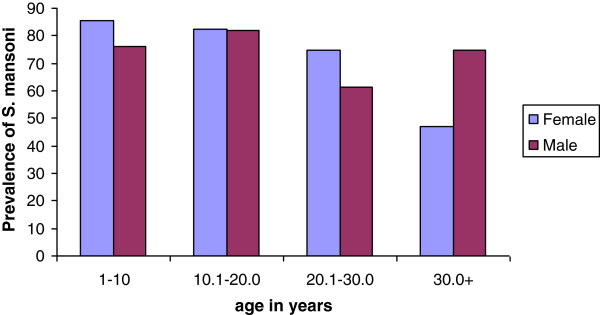
Prevalence of
S. mansoni
by sex, Waja-Timuga, Dec. 2011-Mar. 2012.